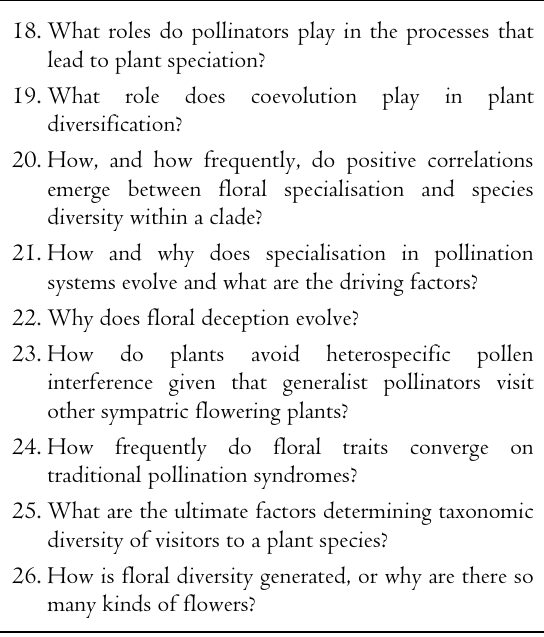
Box 4: Questions on evolution of animal-mediated pollination Three methodological approaches and lines of